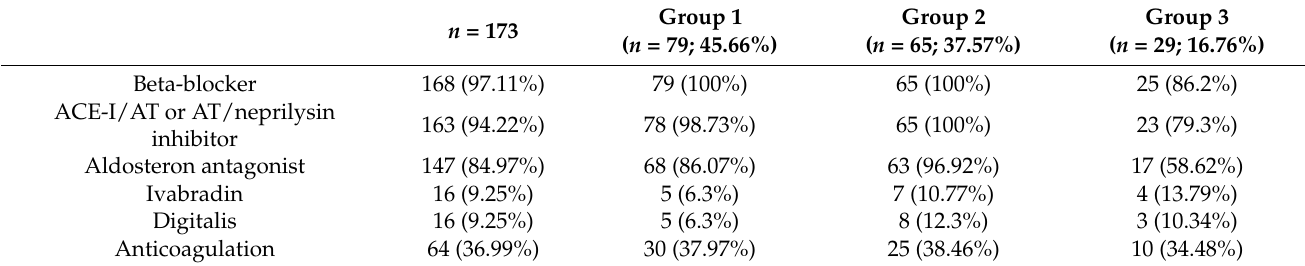
Table 2. Medication at